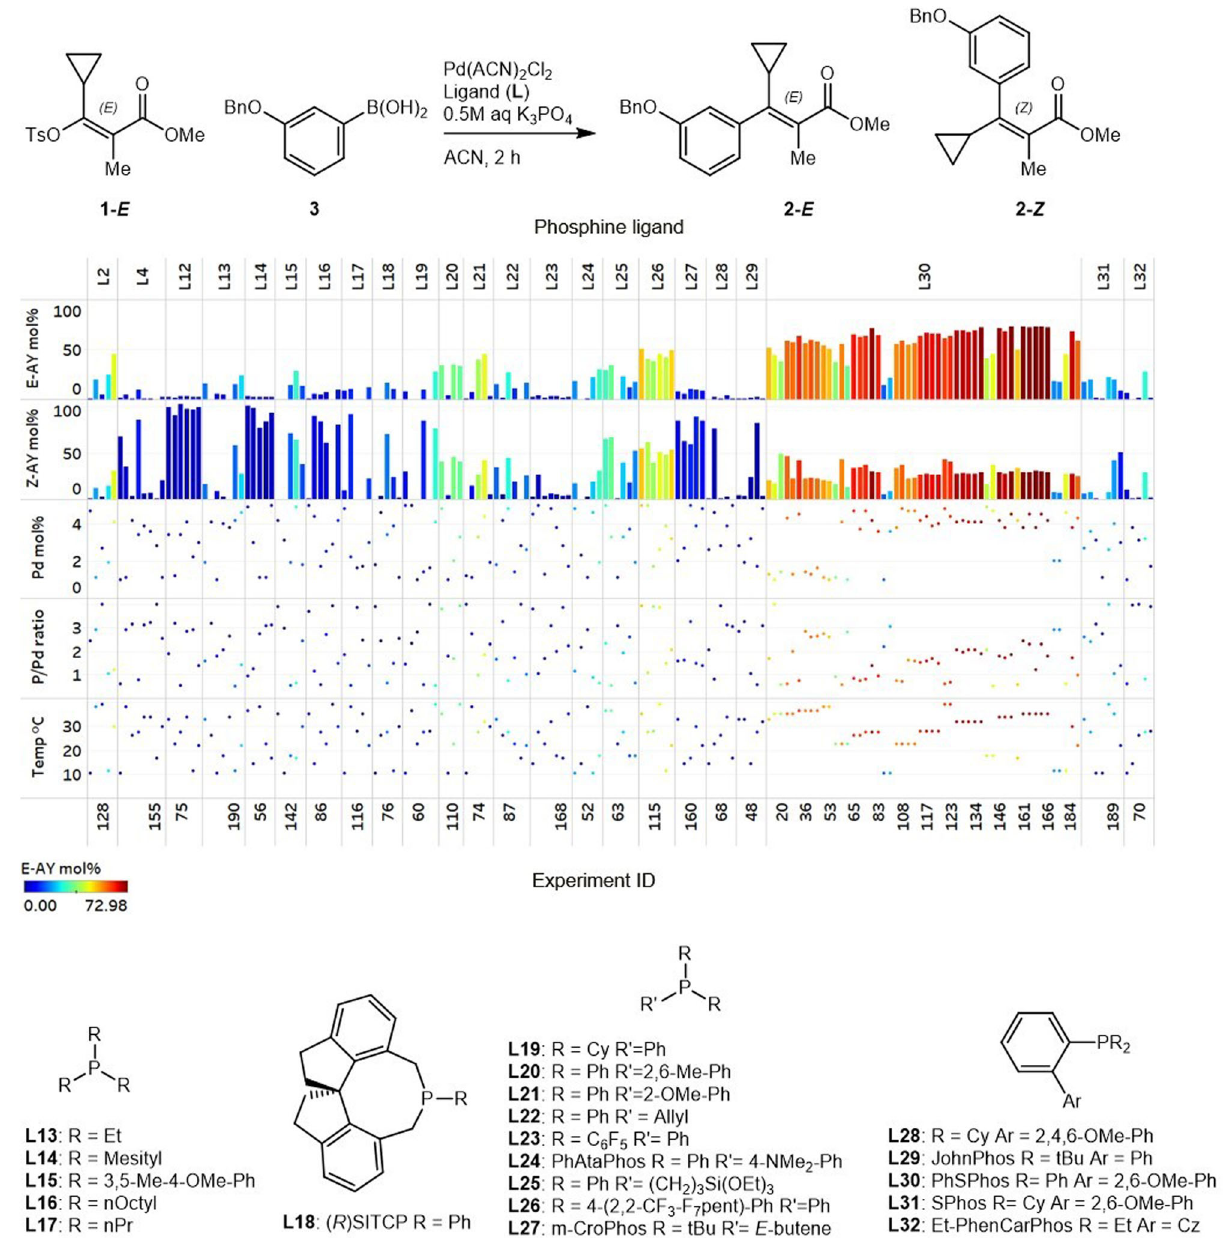
Fig. 6 Parameters and results of optimization with ligands selected through descriptor clustering in campaign 2. Conditions: 10 µ mol 1- E , 1 µ mol 1,3,5- trimethoxybenzene, 15 µ mol (3-(benzyloxy)phenyl)boronic acid 3, 0.1 – 0.5 µ mol Pd(ACN) 2 Cl 2 , 0.05 – 2 µ mol L, 30 µ mol K 3 PO 4 (0.5 M aq) in ACN (0.05 M), 2 h at 10 – 40 °C. Tabulated results are provided in Supplementary Information Table SI-11. An animated chart of E -product yield over time is provided as Supplementary Movie